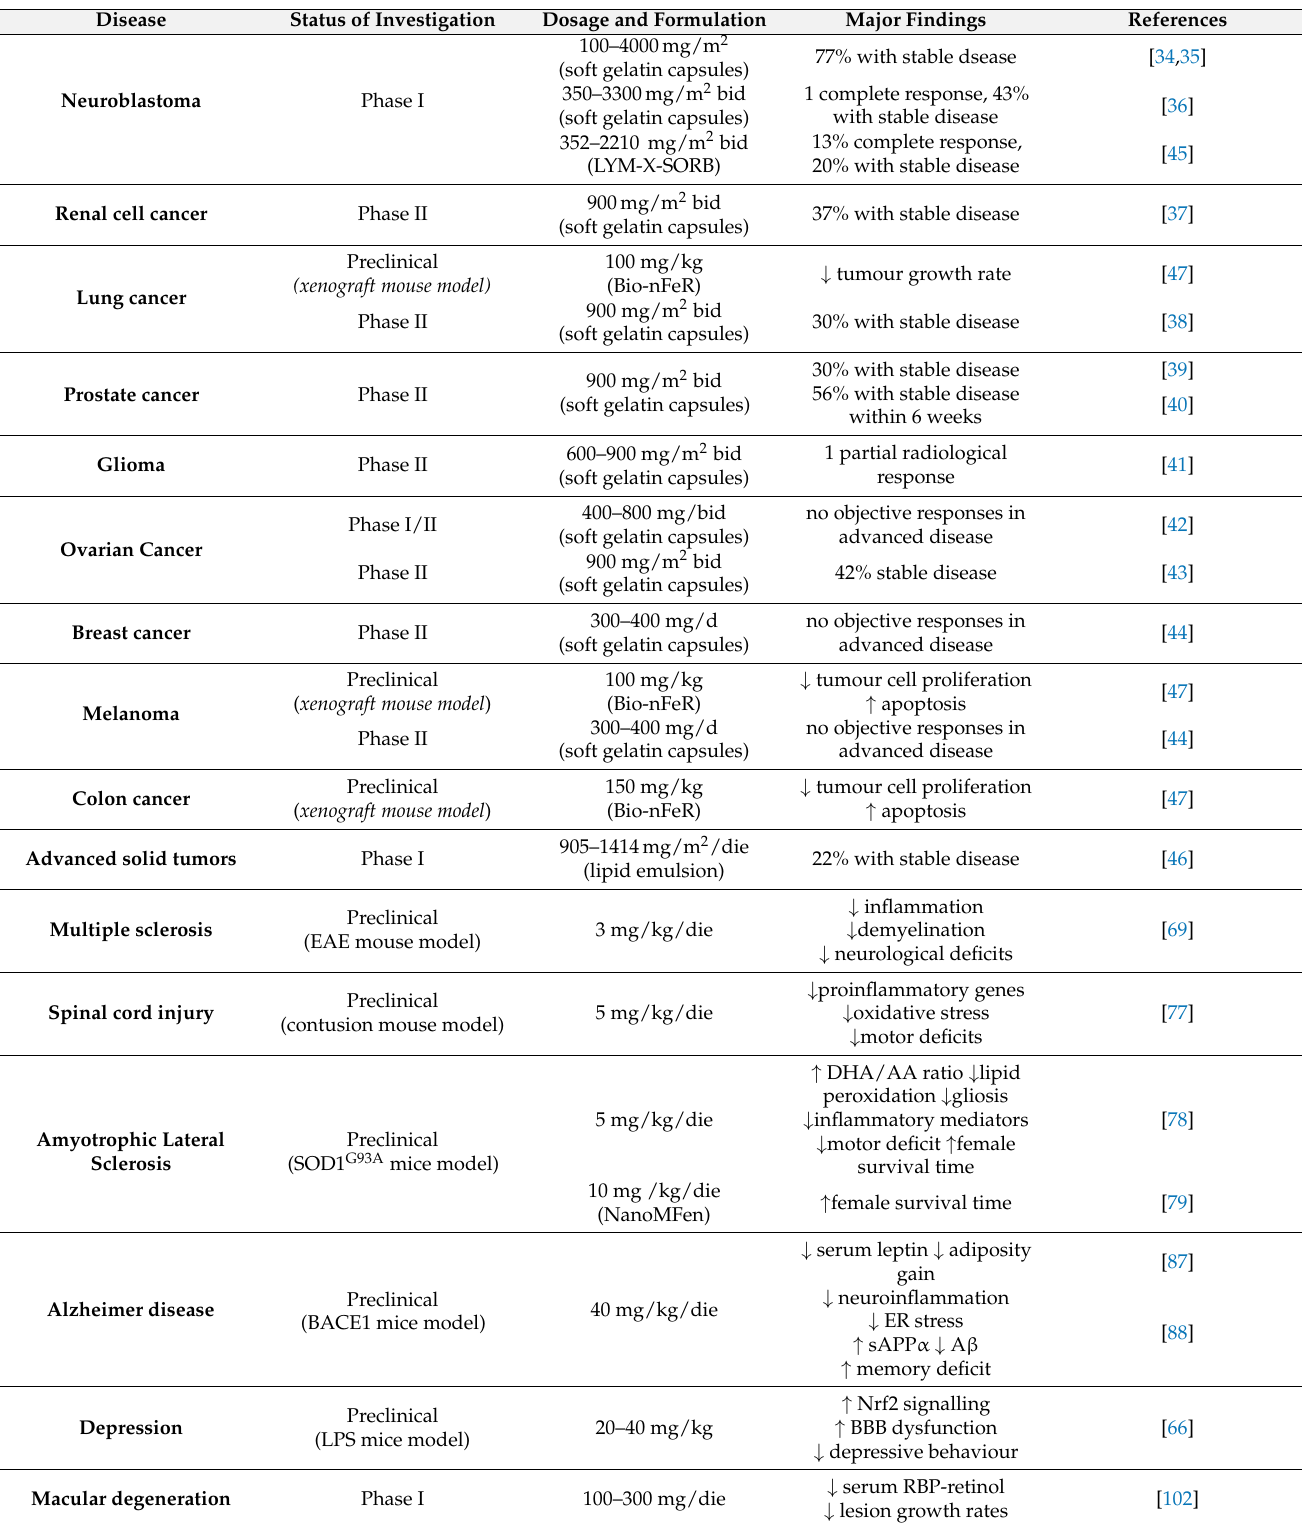
Table 1. Summary of studies evaluating the effects of fenretinide in cancer and neurological diseases. ↑ increased, ↓ decreased, bid bis in die